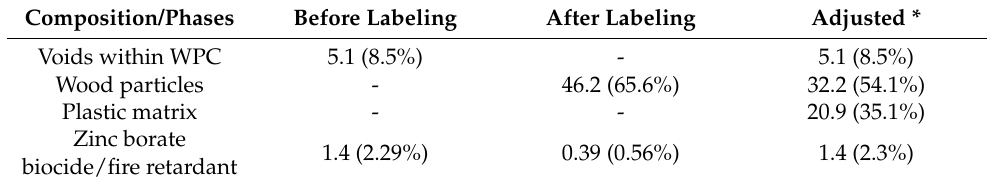
Table 1. Volumes (mm 3 ) of phases in the WPC sample (percentage in